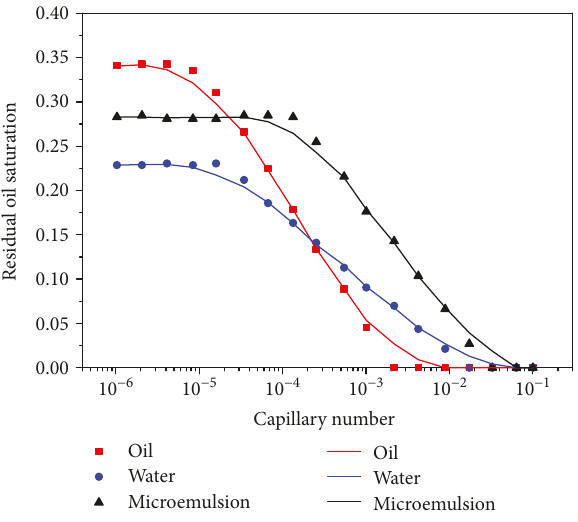
Figure 1: Example of a capillary desaturation curve (CDC) [2].